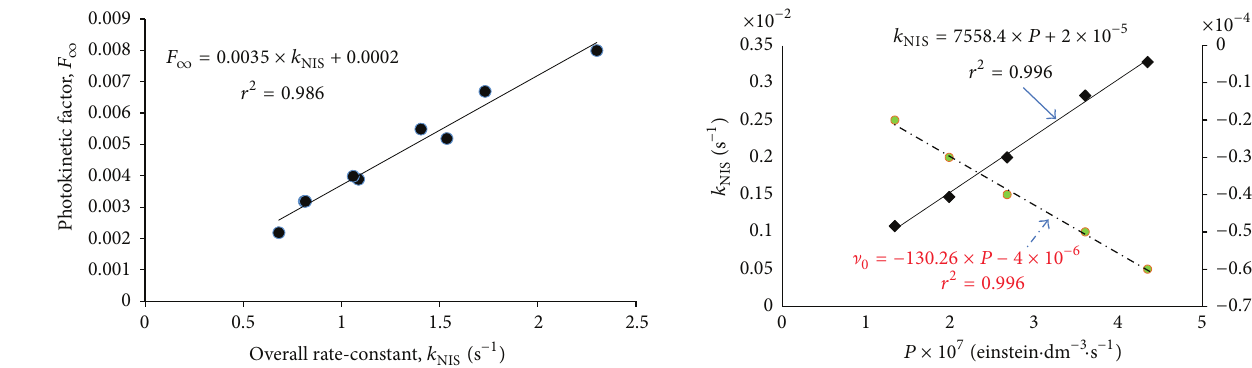
Figure 7: Linear relationship between 𝐹 𝜆 irr ∞ and 𝑘 𝜆 irr NIS for data collected for both TRZ and QY various concentrations (Table 3) in the presence of 1.56 × 10 −5 M NIS irradiated and observed at 390 nm.